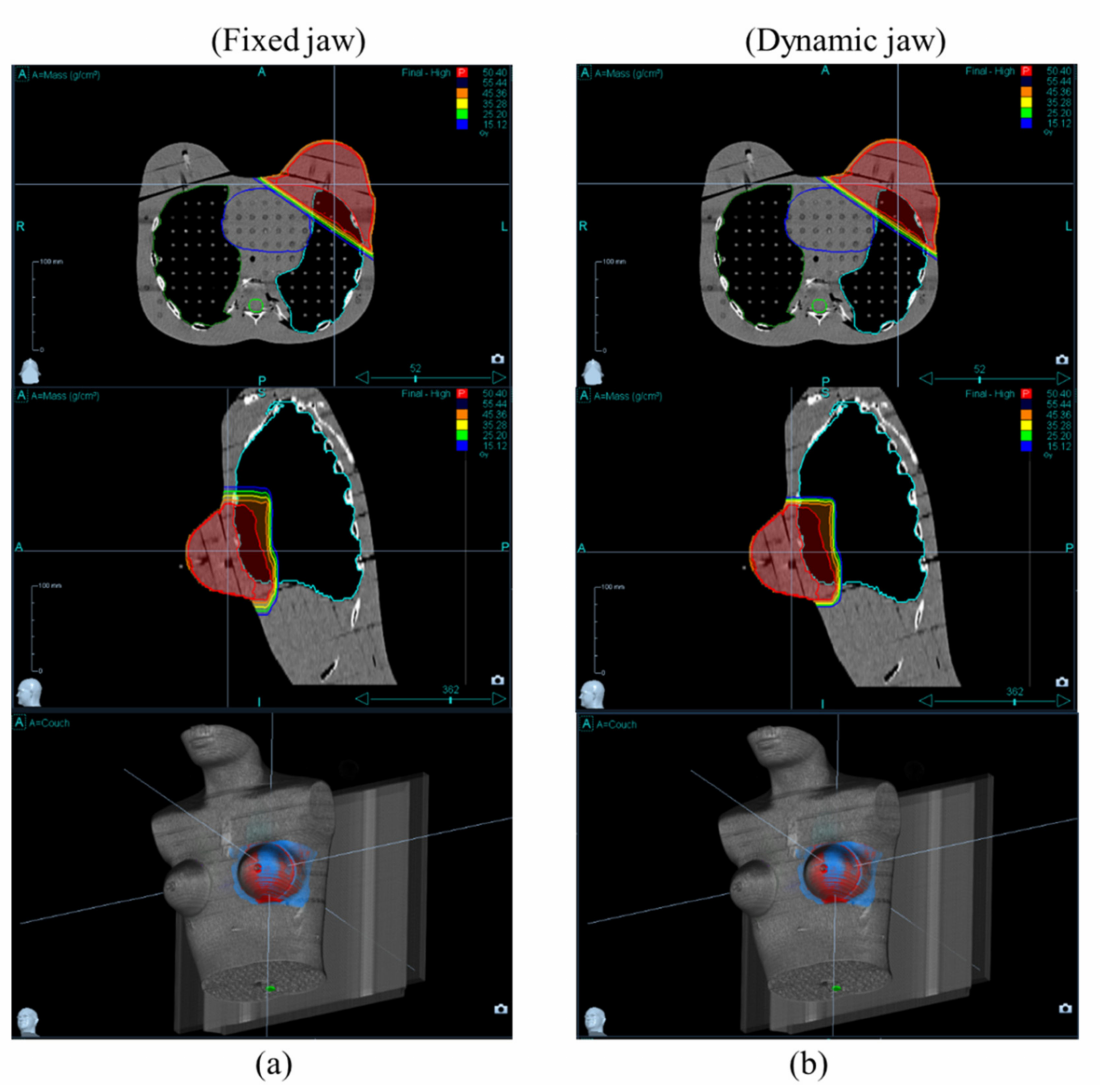
Figure 5. CT images (upper and middle rows) and 3D dose distribution (lower row) between jaw modes in ( a ) fixed and ( b ) dynamic jaw modes at the field width of 2.5 cm. The red and blue colors indicate target coverages of over 95% and 30% of the prescription dose,